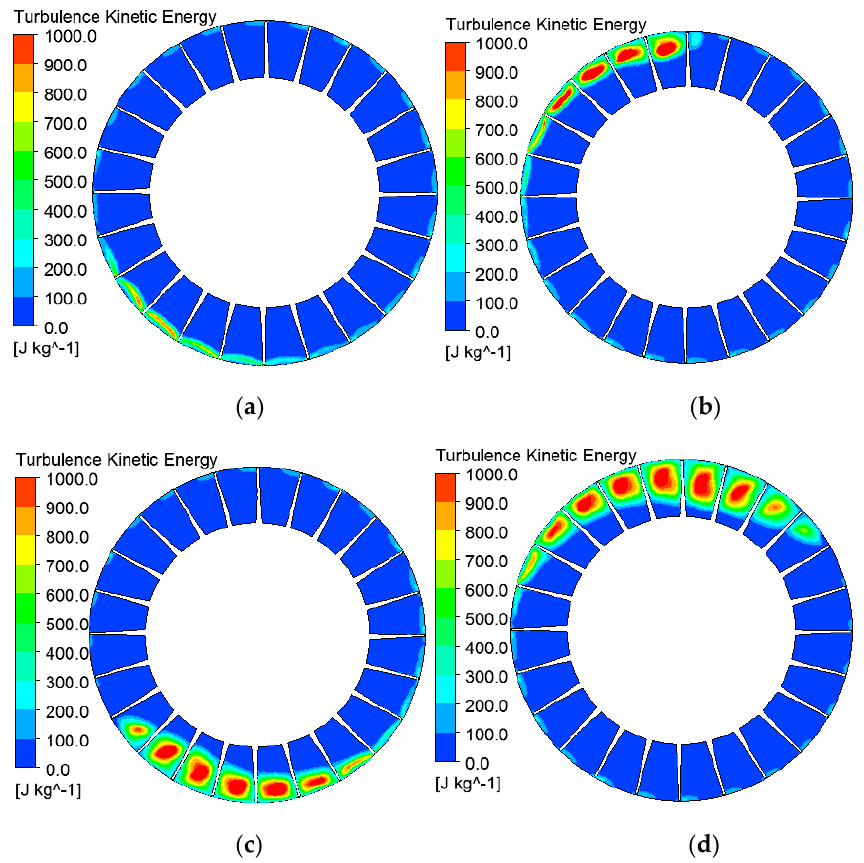
Figure 10. Turbulent kinetic energy contour of the first rotor midsection when the abnormal angle equal to − 6 ◦ . ( a ) Near stall inception at 11 T , ( b ) stall inception start at 13 T , ( c ) development of stall inception at 15 T , and ( d ) complete stall cell at 17 T .